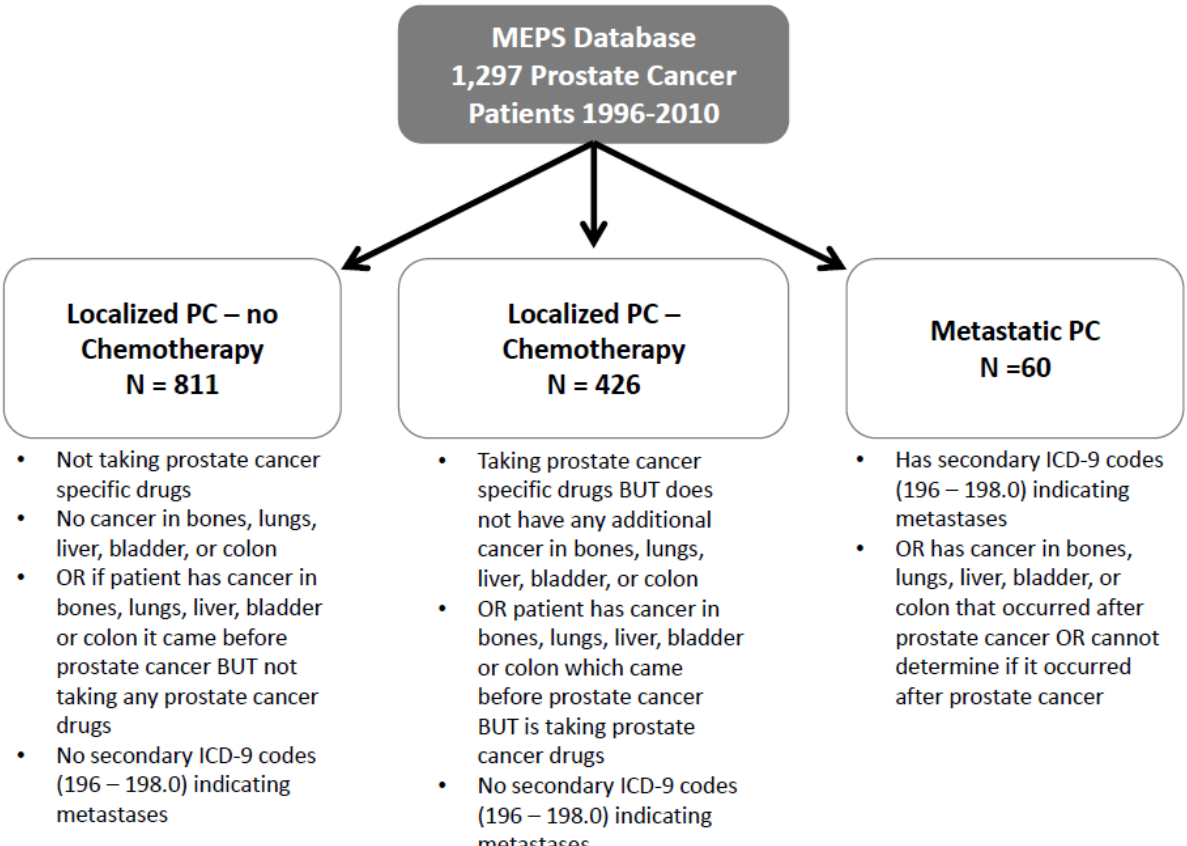
Figure 1. PC Severity